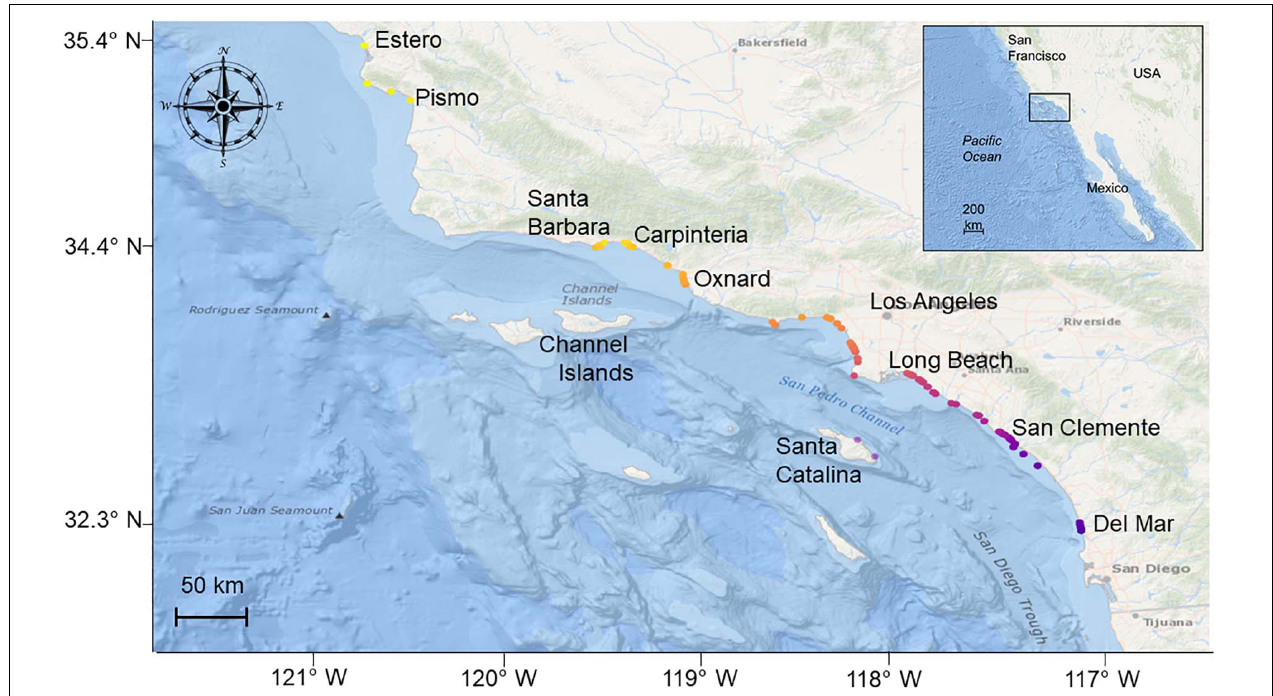
FIGURE 1 | Study area (inset) and locations of all receivers used in the study (2014–2019). Receiver locations are colored according to